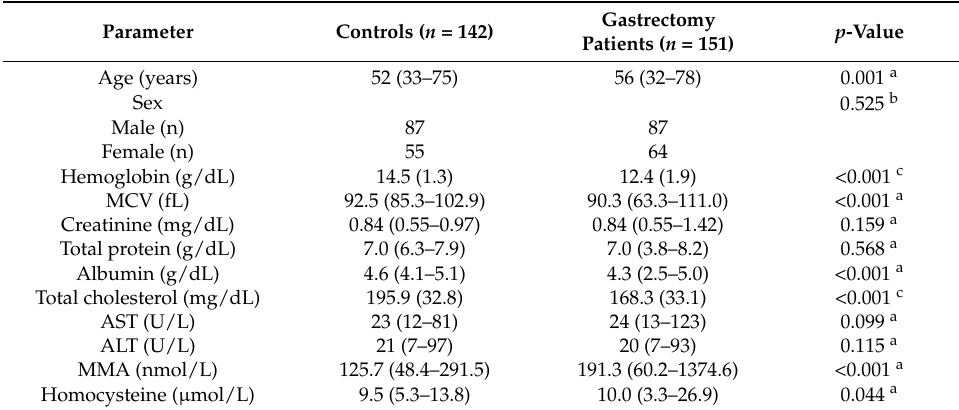
Table 1. Comparison of demographic characteristics and biochemical markers between the control group ( n = 142) and the gastrectomy patient group ( n =